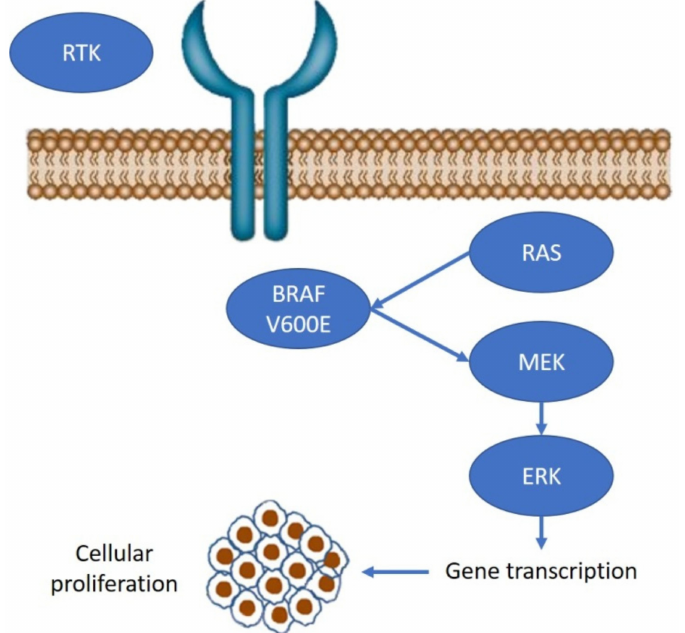
Figure 1. Mitogen-activated protein kinase (MAPK) pathway in BRAF V600E-mutated metastatic colorectal cancer (mCRC). RAS activates the RAF family proteins (ARAF, BRAF, and CRAF). Activated RAF proteins lead to phosphorylation and activation of MEK1 / 2 proteins, which subsequently phosphorylate and activate ERKs, leading to cell